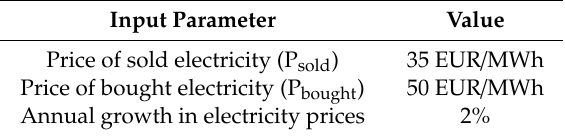
Table 7. Short-term market electricity prices used in the economic model.